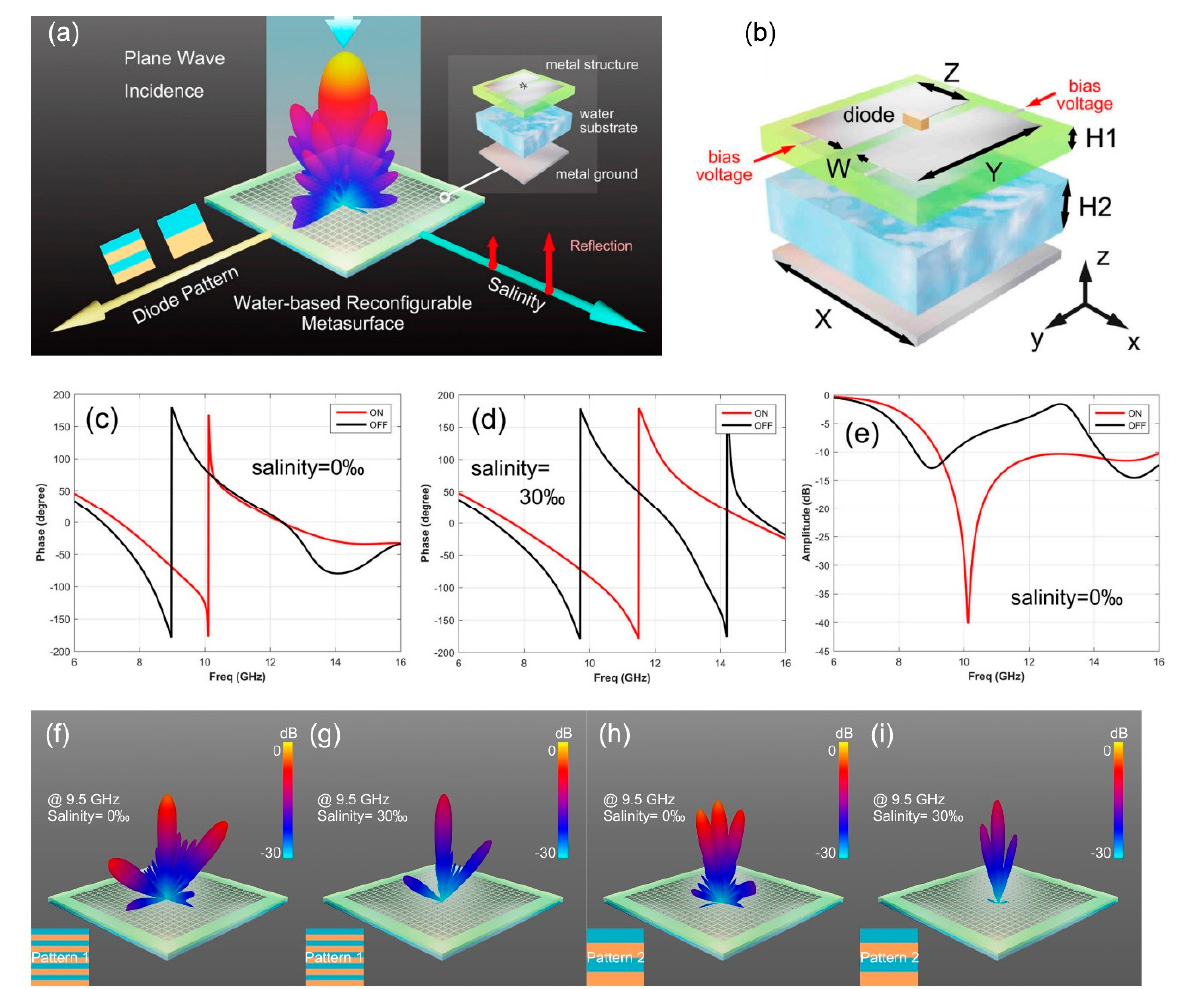
Figure 4. ( a ) Schematic of programmable metasurface based on water and integrated with PIN diodes (from Figure 1 of Ref. [112]). ( b ) Detailed structure of the metasurface element (from Figure 2a of Ref. [112]). ( c ) The reflected phase response of PIN diode switching state when salinity is 0% (from Figure 2c of Ref. [112]). ( d ) The reflected phase response of PIN diode switching state when salinity is 30% (from Figure 2d of Ref. [112]). ( e ) The reflected amplitude response of PIN diode switching state when salinity is 0% (from Figure 2e of Ref. [112]). ( f , g ) The three-dimensional far-field results of pattern 1 for salinity of 0% and 30% at 9.5 GHz (from Figure 6a,b of Ref. [112]). ( h , i ) The three-dimensional far-field results of pattern 1 for salinity of 0% and 30% at 9.5 GHz (from Figure 7a,b of Ref. [112]). Reproduced with permission from Ref. [112] provided by AIP Publishing and Copyright Clearance Center, license number: